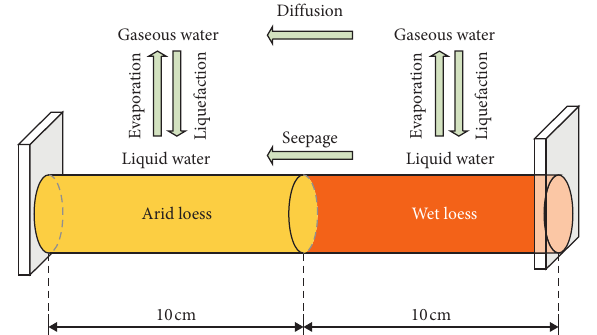
Figure 7: Test apparatus for water